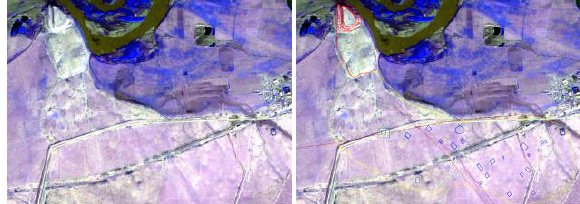
Figure 18a, b - Kushaf - a RGNIR synthesis of the FORMOSAT-2 images (acquired on 24.10.2014) with overlaid objects of interest on the left picture